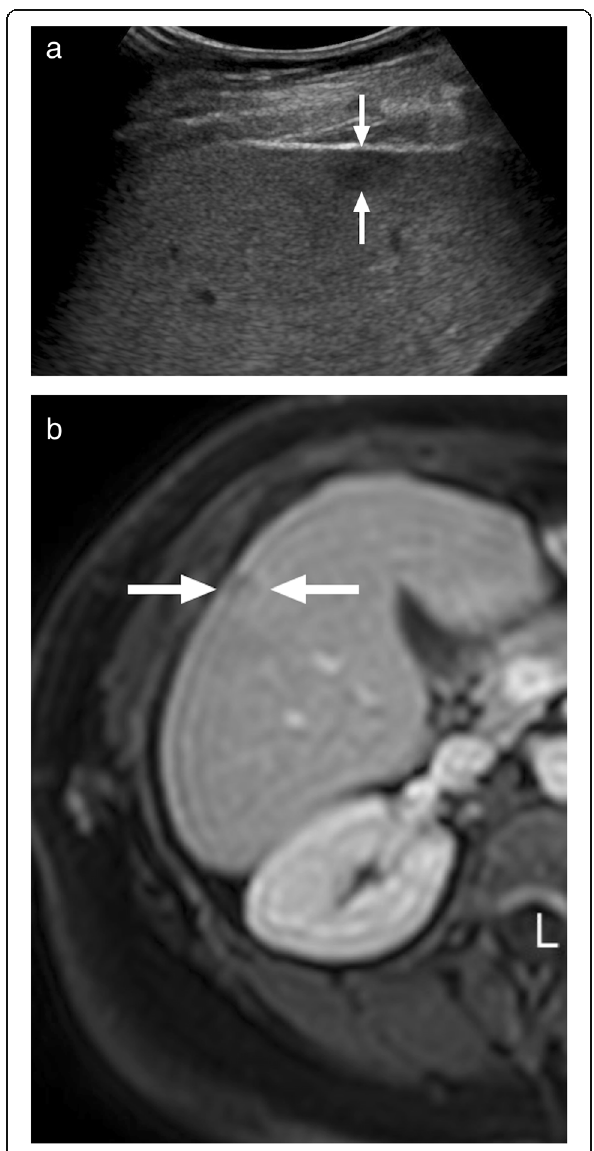
Fig. 10 A 50-year-old female with known breast cancer in remission was referred to MRI study after detection of a subcentimeter focal liver lesion on US exam. a US study showed subcapsular, hypoechoic solid appearing mass (arrows). b Axial plane postcontrast T1W image showed the same lesion as a hypointense mass with peripheral contrast enhancement (arrows). DW images and ADC map confirmed significant diffusion restriction (not shown). Percutaneous biopsy confirmed eosinophilic liver abscess with no evidence of metastatic disease. Subsequent peripheral blood smear also confirmed hypereosinophilia